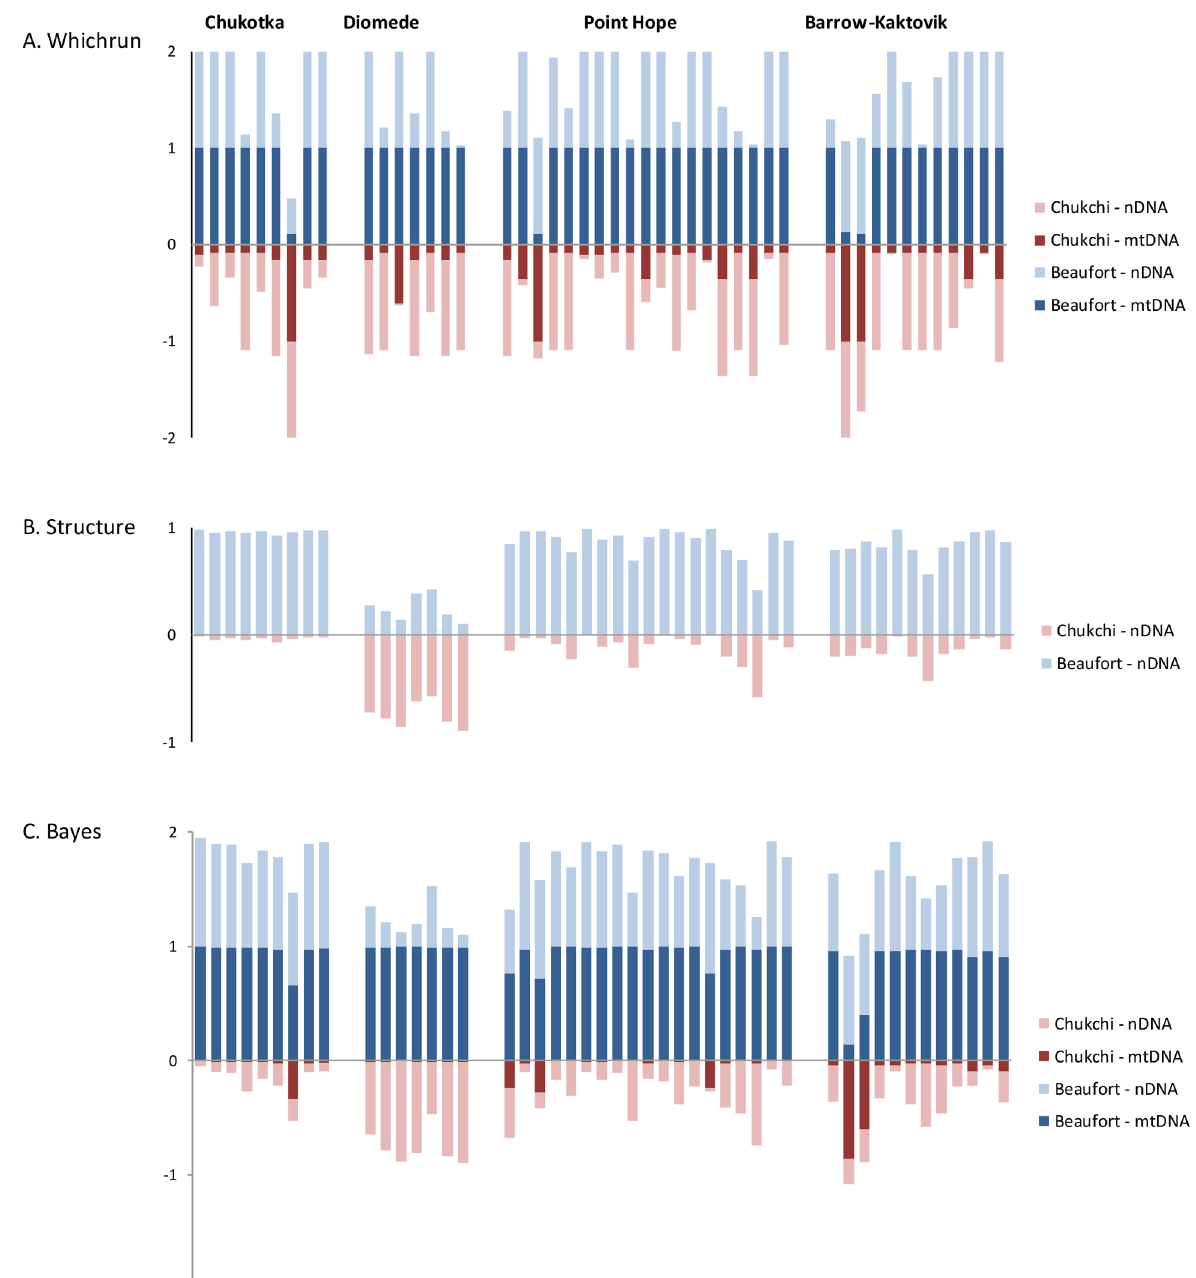
Fig 5. The likely population of origin of beluga whales on spring migration sampled at four locations in the Bering, Chukchi and Beaufort Seas. Individual assignments are represented as the relative height of stacked bars to either of two baseline populations, the eastern Beaufort Sea (blue) or eastern Chukchi Sea (red) for mtDNA (dark shading) and nDNA (light shading). A: Maximun Likelihood assignments in Whichrun. B: Baysian assignments using prior sampling information and admixture models in Structure 2.3.4. C: Mixed-stock assignments in Bayes. Only individuals with complete mtDNA-nDNA profiles are shown. See Table 4 for more